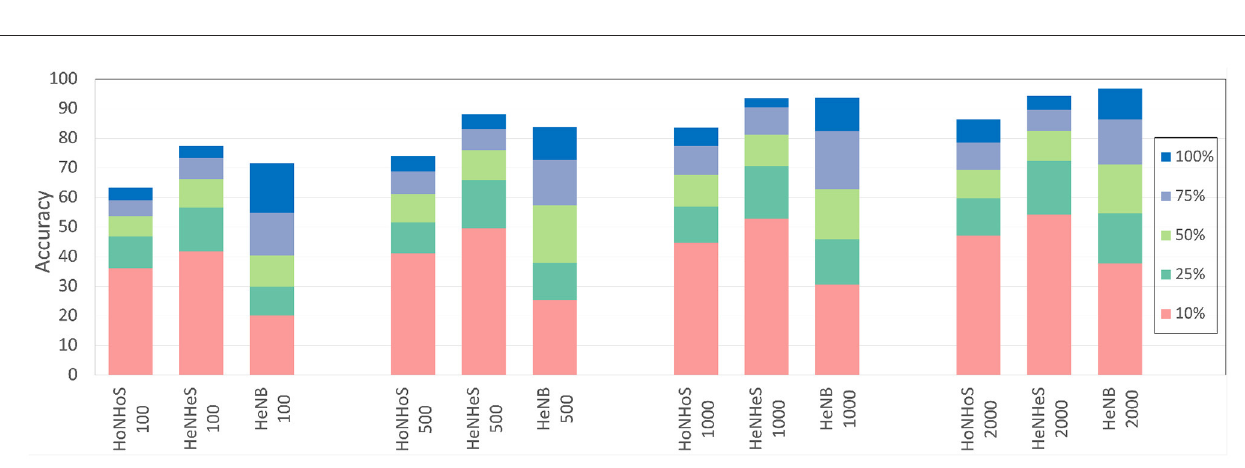
FIGURE7 Bar graph showing difference in performance for the different models with increasing training data for the KTH dataset. A similar trend can be observed for the DVS dataset (shown in Supplementary